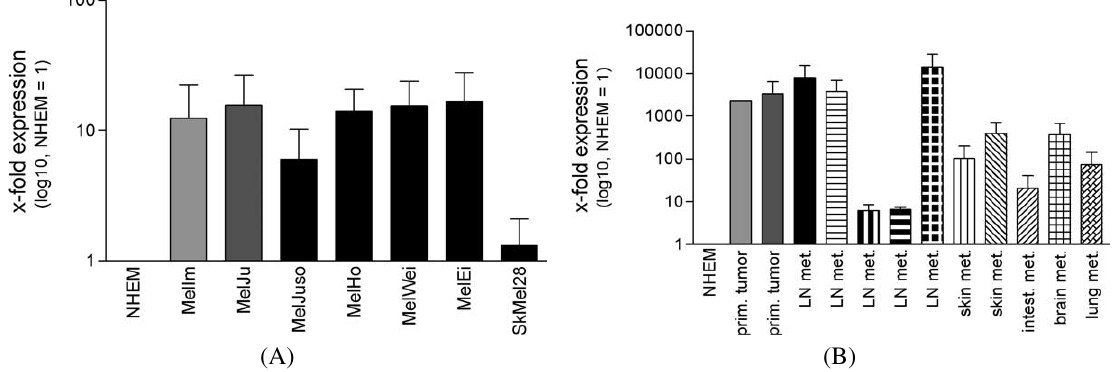
Fig. 1. Integrin alpha10 expression in melanoma cell lines compared to primary melanocytes. (A) Integrin alpha10 mRNA expression was quan- tified by real-time PCR. All melanoma cell lines showed strong induction of integrin alpha10 expression compared to normal human epidermal melanocytes (NHEM) except of SK Mel 28. (B) RNA was extracted from tissue samples of 2 primary melanomas (prim. tumor), 5 lymph node metastases (LN met.) and 5 distant metastases (skin met., intest. met., brain met., lung met.) by microdissection and analyzed by real-time PCR. Expression of integrin alpha10 mRNA was compared to normal human epidermal melanocytes (NHEM). Induction of expression of integrin alpha10 was found in all melanoma samples. (C) Integrin alpha10 protein expression in chondrocytes, NHEM and melanoma cell lines was analyzed by western blot analysis. In melanoma cell lines expression was induced compared to NHEM. As loading control the blot was coun- terstained with a ß-actin antibody. (D) Localization of integrin alpha10 expression was analyzed using cytoplasm, membrane and nuclear protein fractions isolated of Mel Im cells. Western blot analysis revealed membrane localization of integrin alpha10. (E) Immunostaining of integrin alpha10 revealed strong signals in primary melanoma compared to normal skin. (I) integrin alpha10 stained melanoma tissue (200 × magnifica- tion; bv: blood vessel, mm: malignant melanoma), (II) normal skin (400 × magnification), (III) negative control treated with rabbit serum (200 × magnification), (IV) negative control treated with an isotype specific IgG antibody (200 × magnification). (F) Integrin alpha10 protein expression in primary melanomas and melanoma metastases detected by western blot analysis. In melanoma tissues expression was induced compared to normal skin. As loading control the blot was counterstained with ß-actin antibody. (G) Analysis of collagen type II expression in melanoma cell lines and NHEM of two different donors by RT-PCR. In all melanoma cell lines examined collagen type II was detectable, whereas no expression was seen in